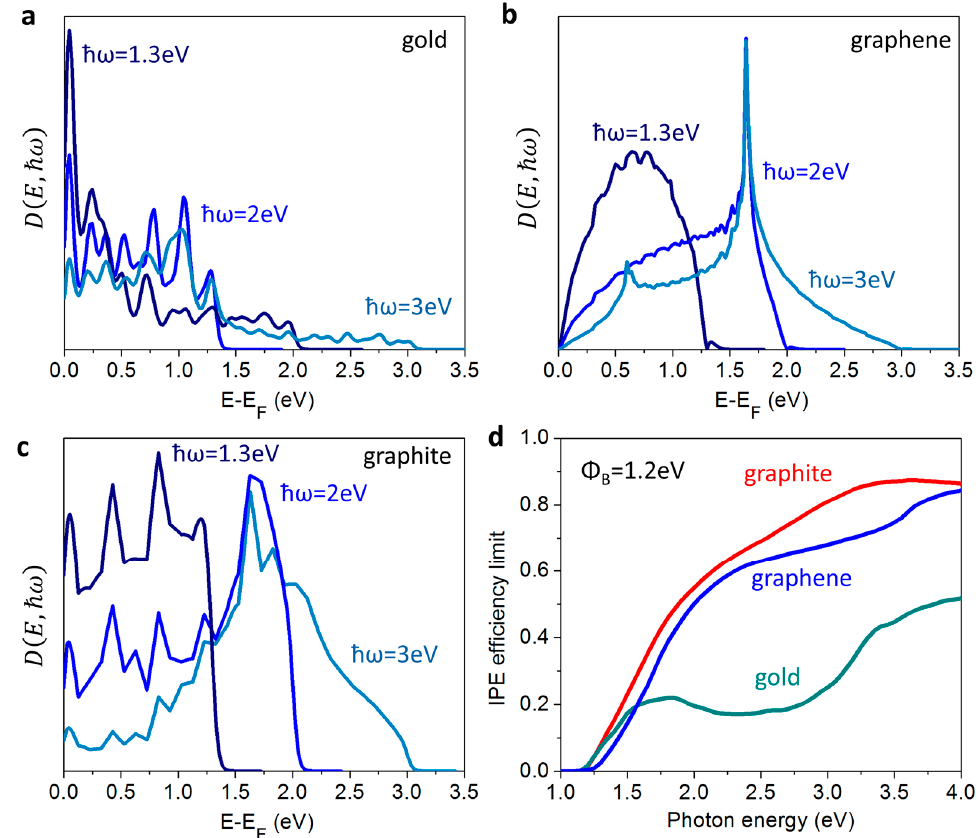
Figure 3. ( a – c ) Joint density of states (cid:1830)((cid:1831),ℏ(cid:2033)) in Au ( a ); graphene ( b ) and graphite ( c ) for the photon energies ℏ(cid:2033) = 2 eV (blue lines), ℏ(cid:2033) = 1.3 eV (navy lines), and ℏ(cid:2033) = 3 eV (light blue lines); ( d ) Limiting IPE efficiencies as a function of the absorbed photon energy for a fixed barrier height Φ (cid:3003) = 1.2 eV (teal: Au, blue: graphene, red: graphite).